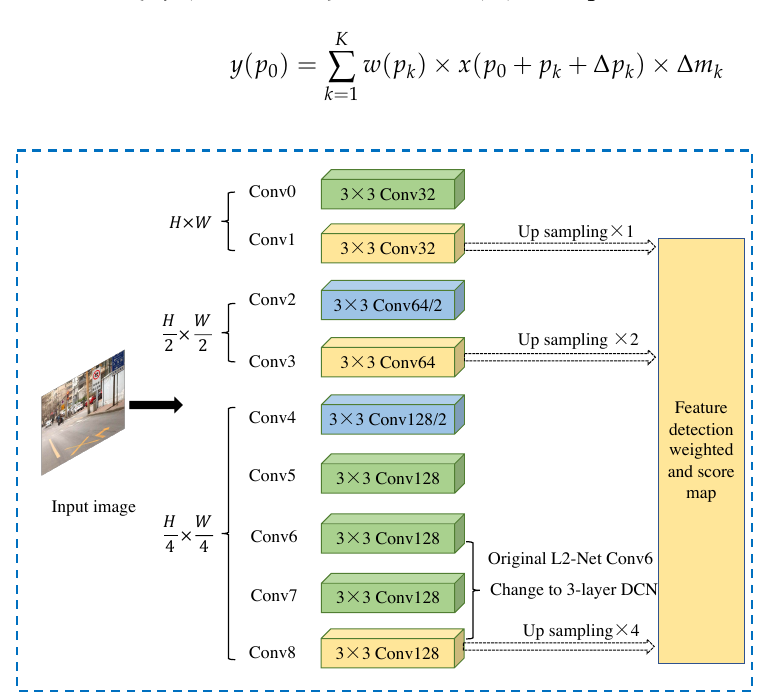
Figure 7. Multi-level deformable network Figure 4.7.Multi-level deformable network infrastructure